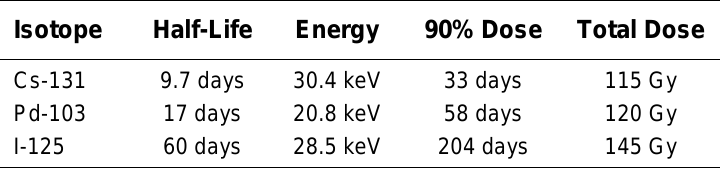
Comparison of Radioactive Seeds in Brachytherapy